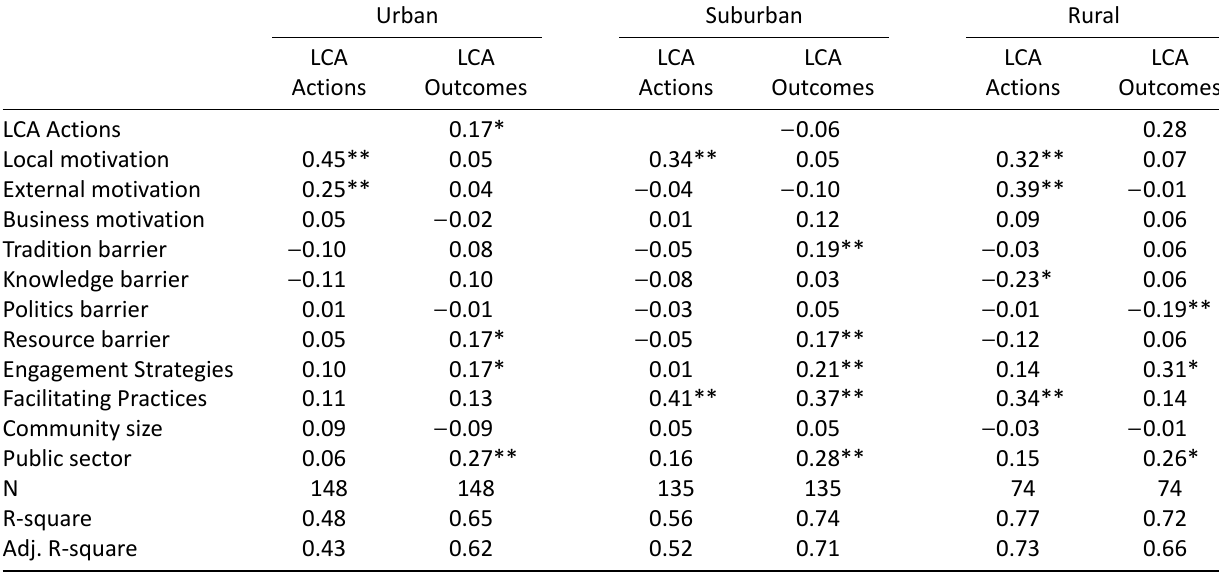
Table 7. Urban/suburban/rural comparison of model results: US subsample. Source: International Planner Engagement Survey (AARP,